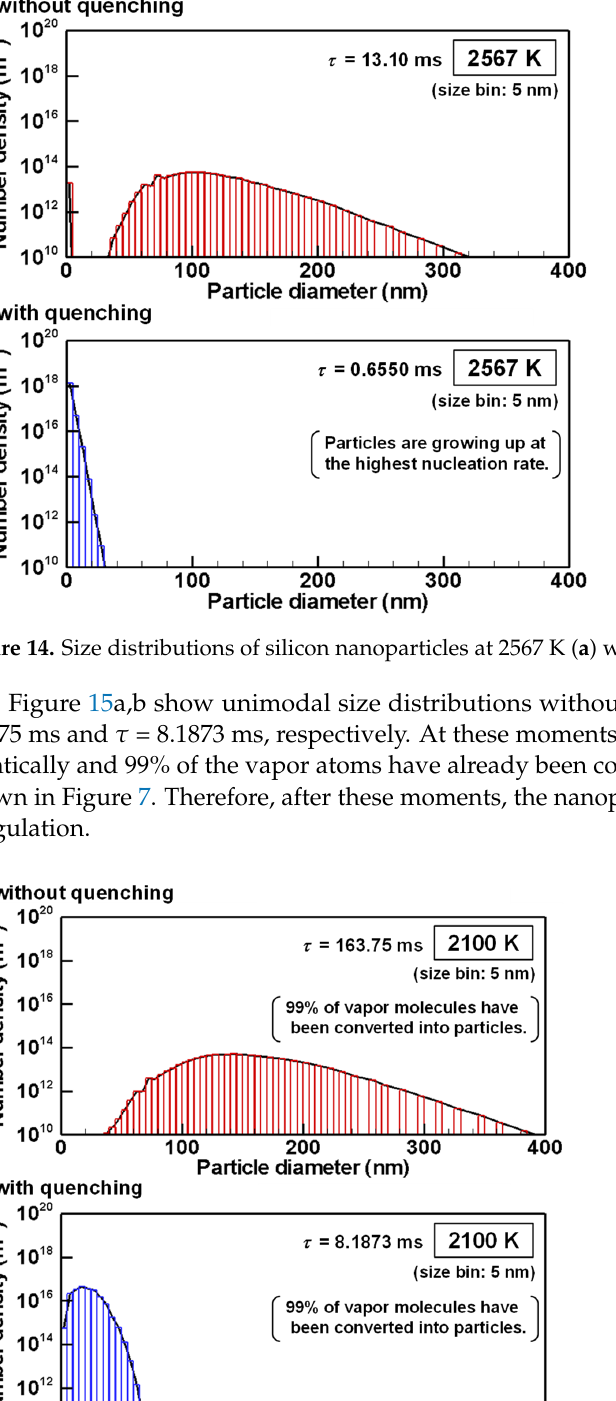
Figure 13. Size distributions of silicon nanoparticles at 2583 K ( a ) without and ( b ) with quenching.